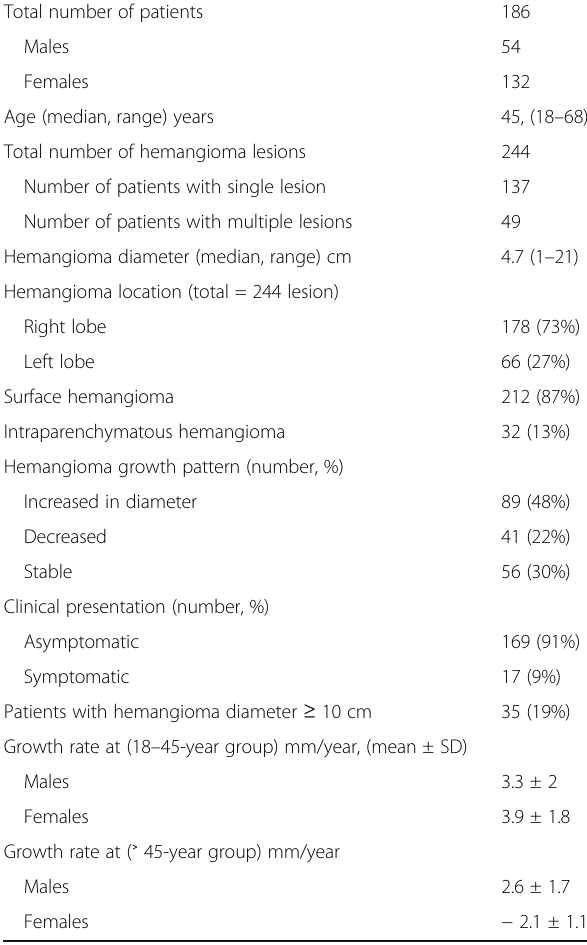
Table 1 Data of hepatic hemangioma patients included in the